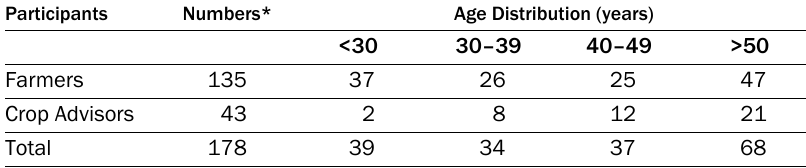
Table 2. Program Attendees by Age Group Who Participated in the